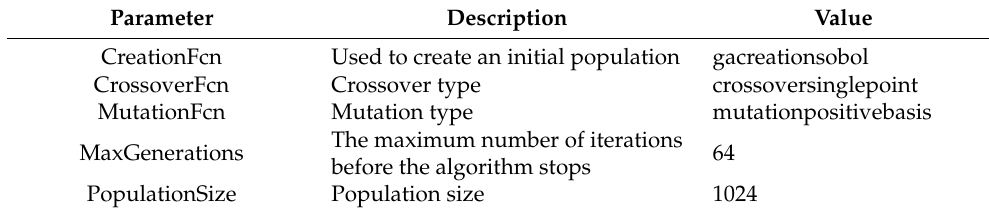
Table 7. Testing parameters used for gamultiobj .